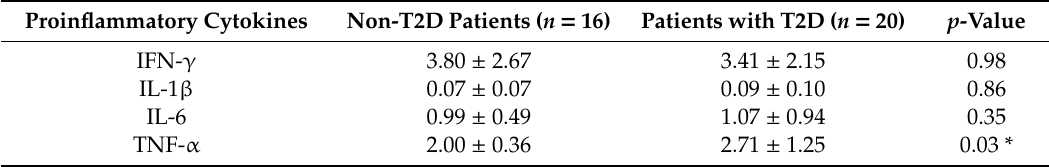
Table 3. Cytokine plasma levels in non-diabetic patients (Non-T2D) and patients with T2D. Proinflammatory Cytokines Non-T2D Patients ( n = 16) Patients with T2D ( n = 20) p -Value IFN- γ 3.80 ±